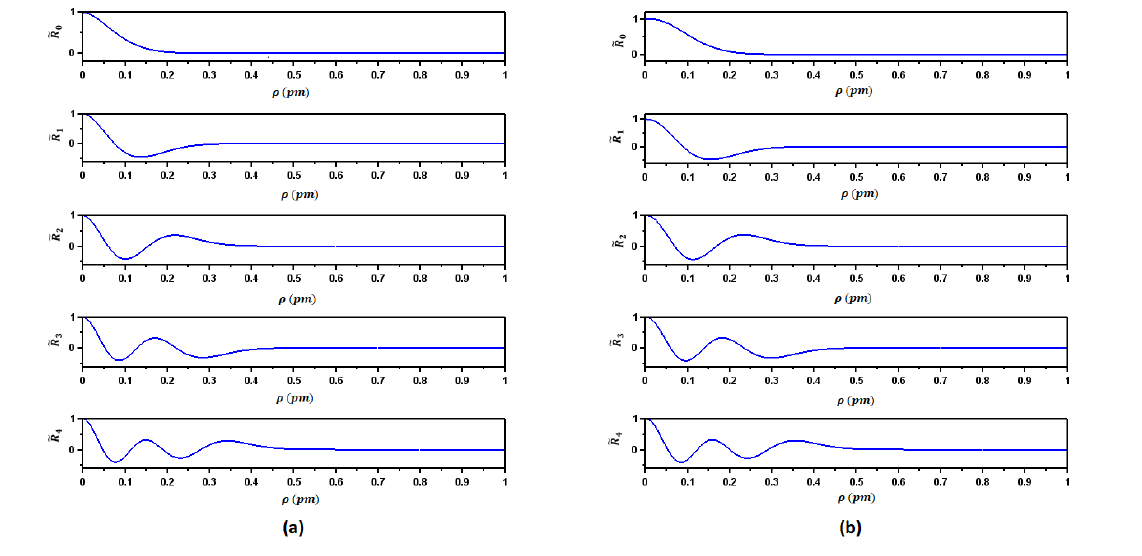
= 10 15 G pm − n , n = − 0.3 and m = 0 for ν = 0 to 4 Figure 6: Wavefunctions for B 0 from the top to bottom panels respectively, for (a) − σ · B , and (b) + σ · B